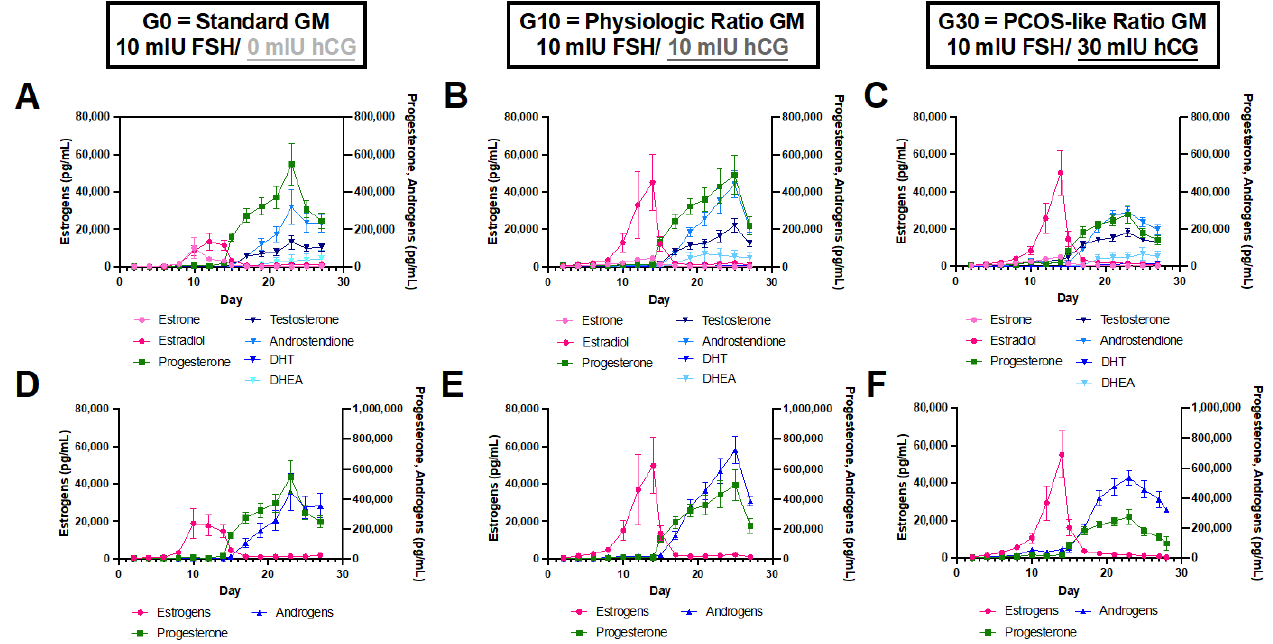
Figure 2. Ovarian explant steroid hormone production across 28-day culture differs in response to different pituitary hormone concentrations. All 7 hormones (estrone, estradiol, progesterone, testosterone, androstenedione, dihydrotestosterone (DHT), and dehydroepiandrosterone (DHEA)) over 28 days for ovaries in ( A ) G0, standard media, ( B ) G10, 1:1 physiologic ratio media, and ( C ) G30, 3:1 PCOS-like ratio media, respectively. ( D ) Estrogens (estrone + estradiol), ( E ) progesterone, and ( F ) androgens (testosterone + androstenedione + DHT + DHEA) across 28 days of culture. Data are presented as mean ± SEM. n = 11–12 samples/group.